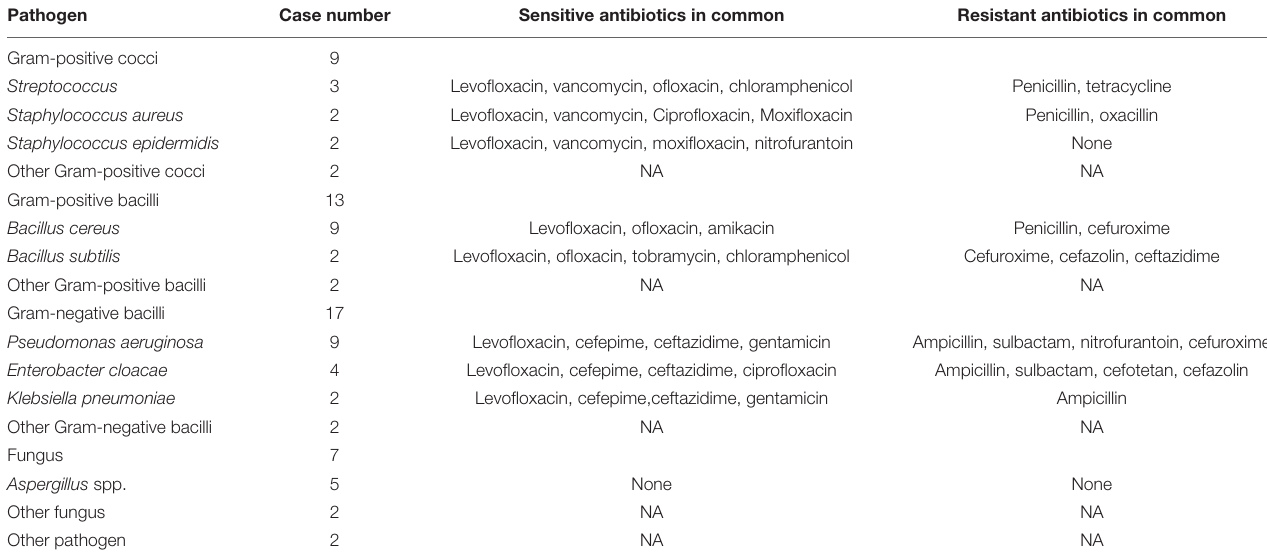
TABLE 5 | Microbiological profile of